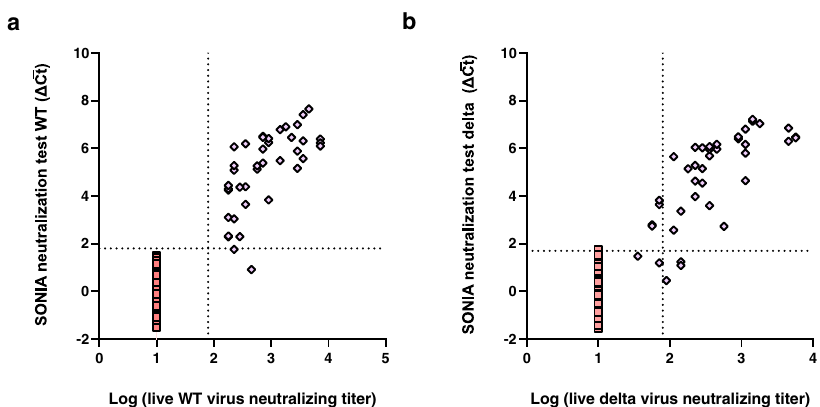
Fig. 7 Multiplex SONIA neutralization test for analysis of NAb against variant of concern (VOC). a Comparison of multiplex SONIA neutralization test for wild type against live wild type virus neutralizing assay (COVID-19 samples in purple diamond and controls in red square). b Comparison of multiplex SONIA neutralization test for delta against live delta virus neutralizing assay (COVID-19 samples in purple diamond and controls in red square). The vertical and horizontal dot lines are the cutoff of positivity for the live virus assay and the multiplex SONIA neutralization assay. The y-axis is the SONIA neutralization PCR test signal Δ Ct calculated by subtracting the Ct value of the sample from that of a buffer only blank control. Table 2 Sensitivity and speci fi city of multiplex SONIA assay using dried blood spot specimens compared to live virus assays ( N = 160).